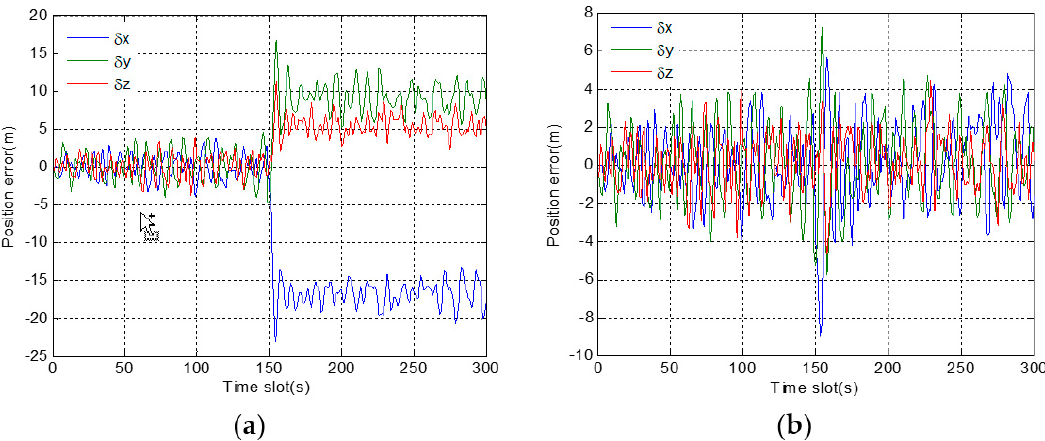
Figure 10. Position error in 3D direction corresponding to abrupt fault: ( a ) before using a robust algorithm; ( b ) after using a robust algorithm.